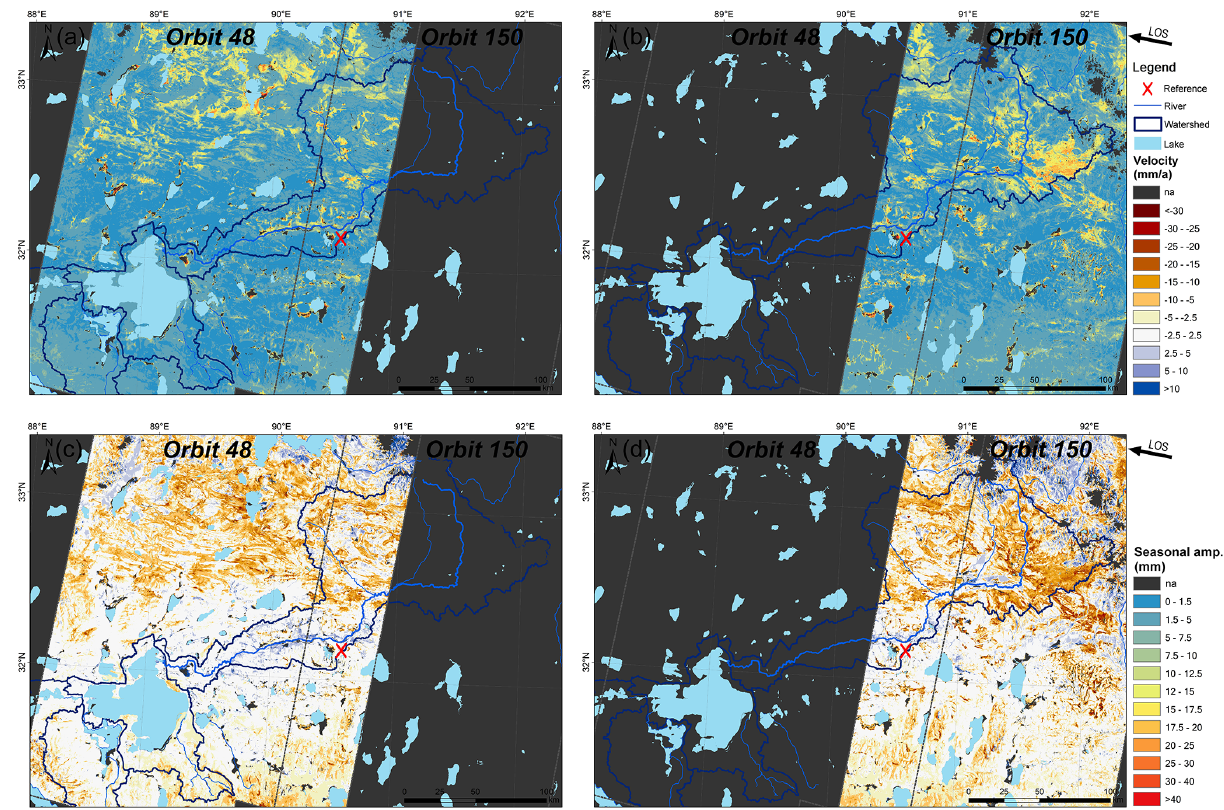
Figure A3. Map of the periodic (seasonal) amplitude (a, b) and long-term velocity (c, d) retrieved from orbit 48 (a, c) and orbit 150 (b, d) , respectively; all are in the satellite LOS